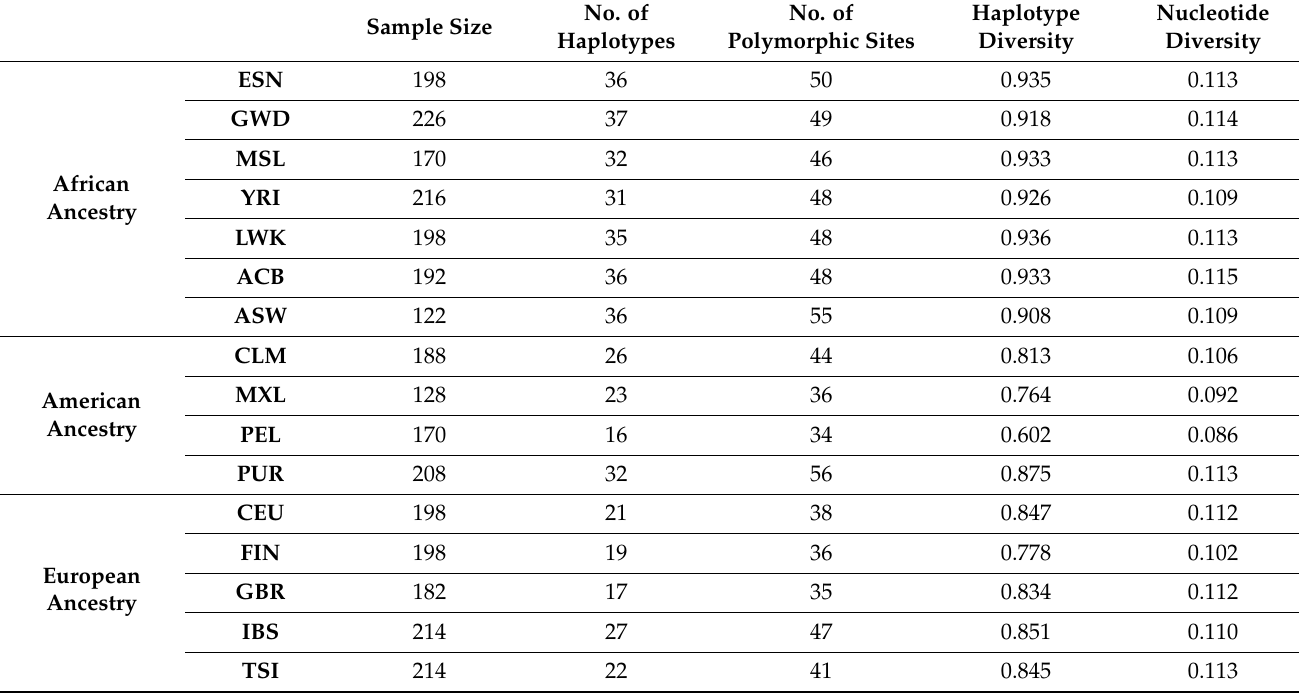
Table 1. The diversity indices in 26 world populations from the 1000 Genomes database. No. of No. of Haplotype Nucleotide Sample Size Haplotypes Polymorphic Sites Diversity